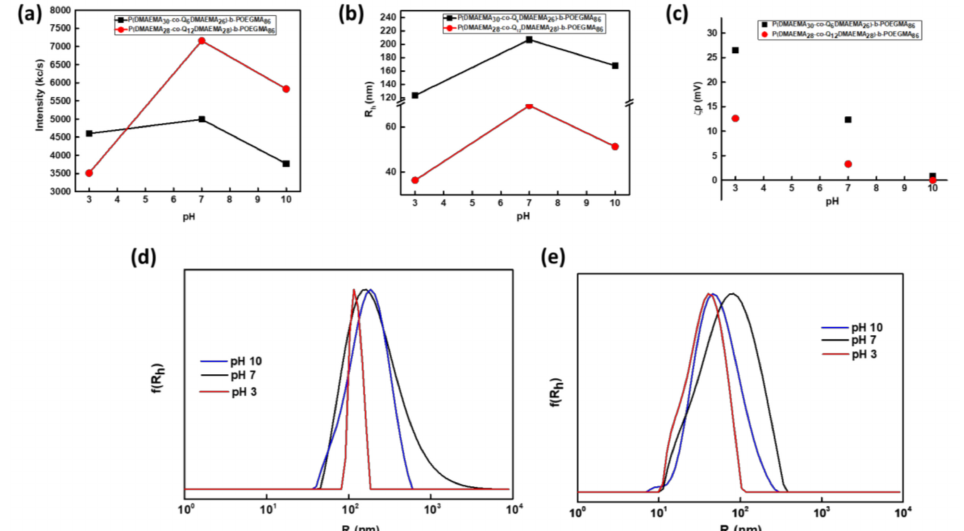
Figure 5. Dependence of ( a ) scattering intensity (I), ( b ) hydrodynamic radius (R h ) and ( c ) surface charge ( ζ p ) for the P(DMAEMA 30 -co-Q 6 DMAEMA 26 )- b -POEGMA 86 and P(DMAEMA 28 -co-Q 12 DMAEMA 28 )- b -POEGMA 86 aqueous solutions on pH-variations and size distribution from CONTIN analysis obtained at 90 ◦ , at pH 7, 3 and 10 for ( d ) P(DMAEMA 30 -co- Q 6 DMAEMA 26 )- b -POEGMA 86 and ( e ) P(DMAEMA 28 -co-Q 12 DMAEMA 28 )- b -POEGMA 86. The preparation protocol was the direct dissolution in aqueous medium and the concentration of the solution 5 × 10 − 3